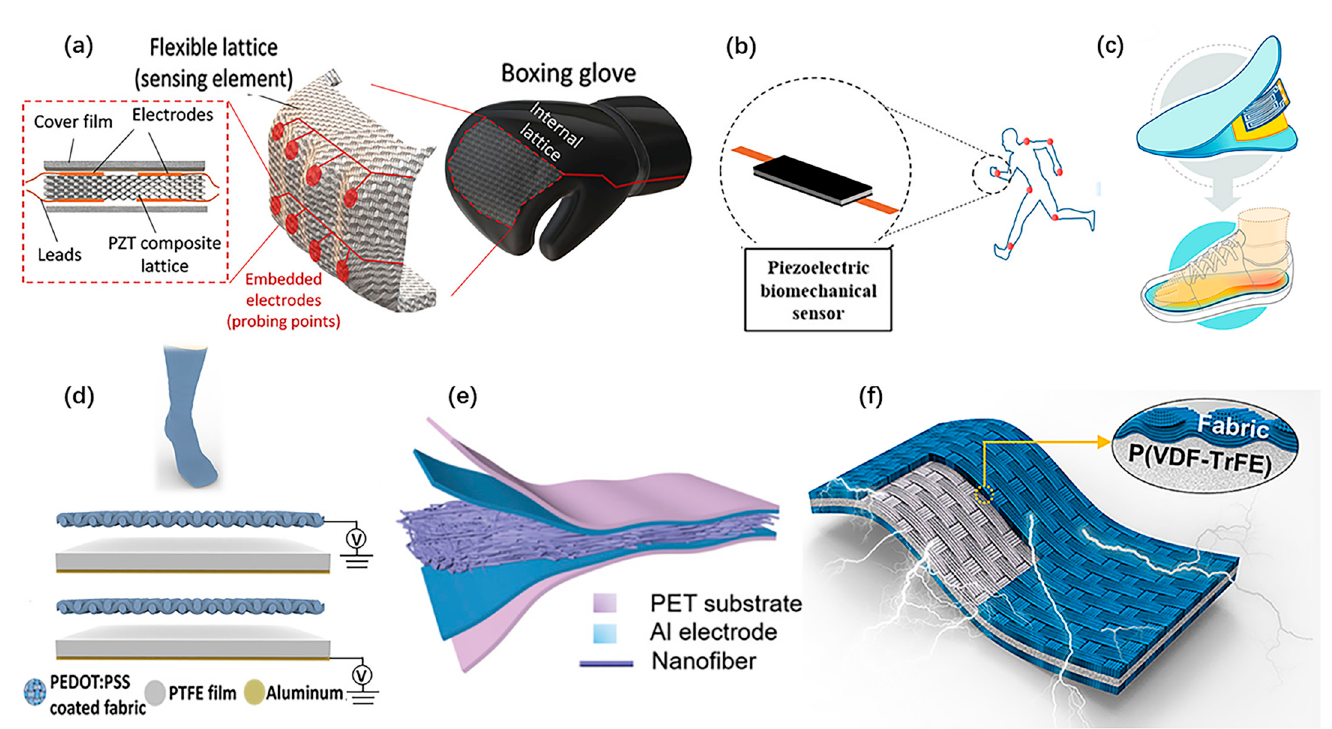
Figure 7. Self-powered wearable systems based on PENG. ( a ) A PENG arrays integrated on a boxing glove for smart sports. Reproduced with permission from Ref. [37]. Copyright © 2019, John Wiley and Sons. ( b ) A highly stretchable